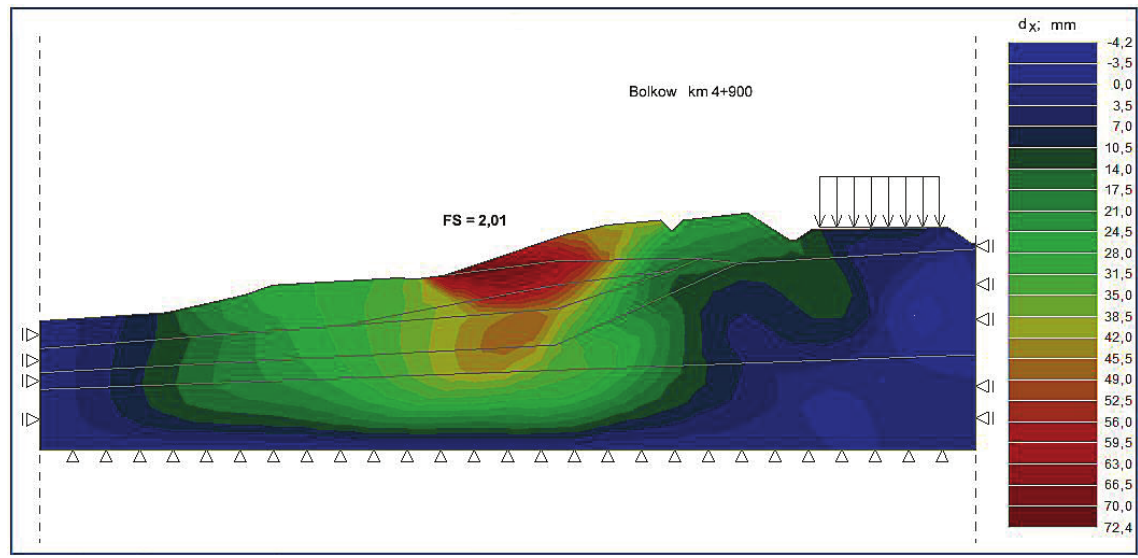
Figure 10: Phase 2 of calculations – stability analysis of the upper part of the slope above the road excavation, F